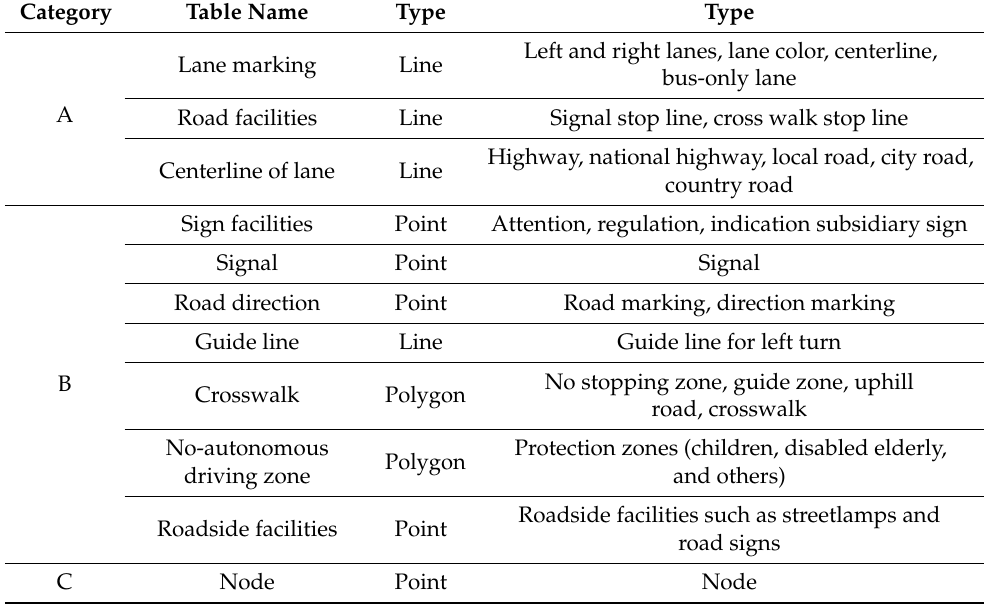
Table 1. Data model of high-definition